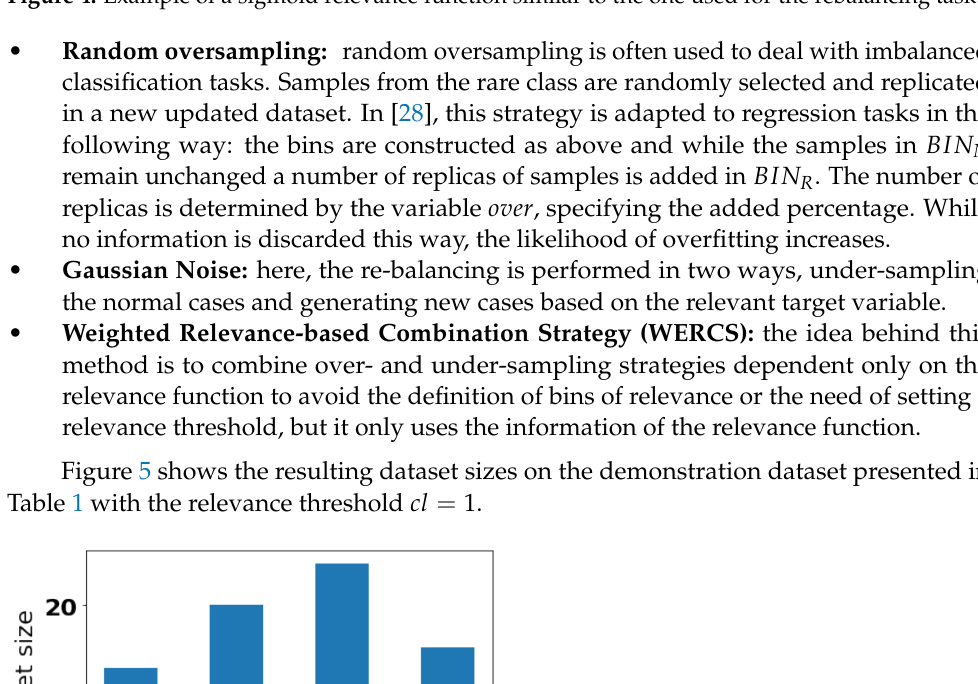
Figure 4. Example of a sigmoid relevance function similar to the one used for the rebalancing task.